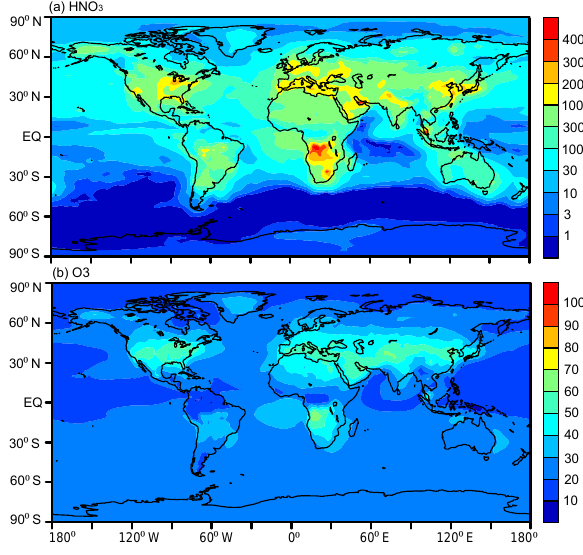
Figure 3. Simulated global distributions of surface-layer HNO 3 (pptv) and O 3 (ppbv) averaged over June–August